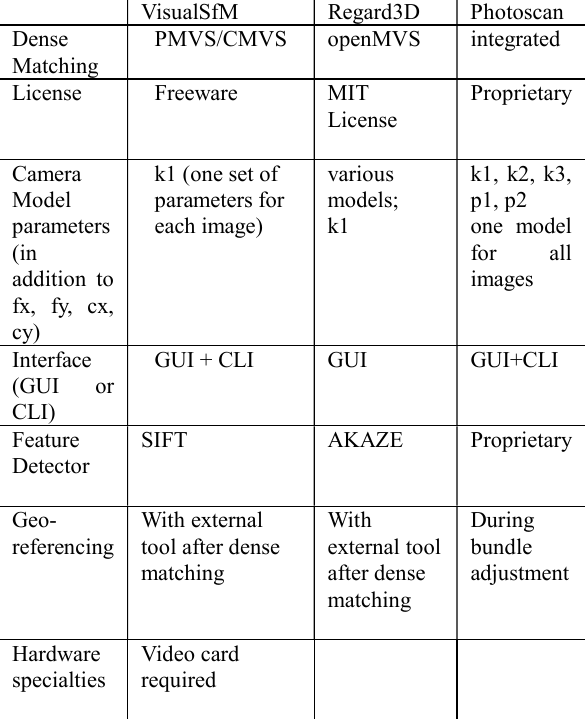
Table 1: Characteristics of the evaluated software